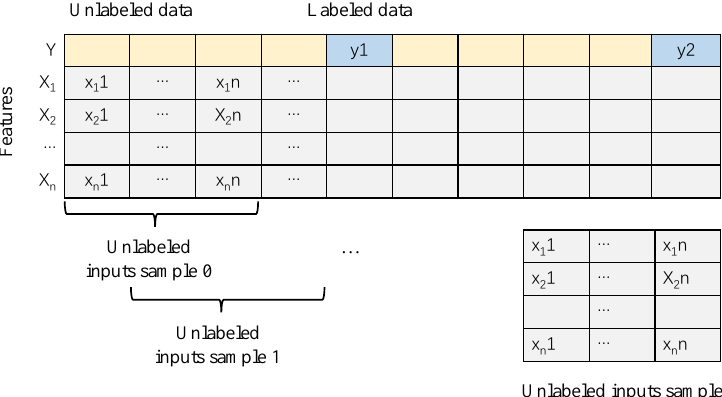
Figure 6. Expansion and serialization of time series